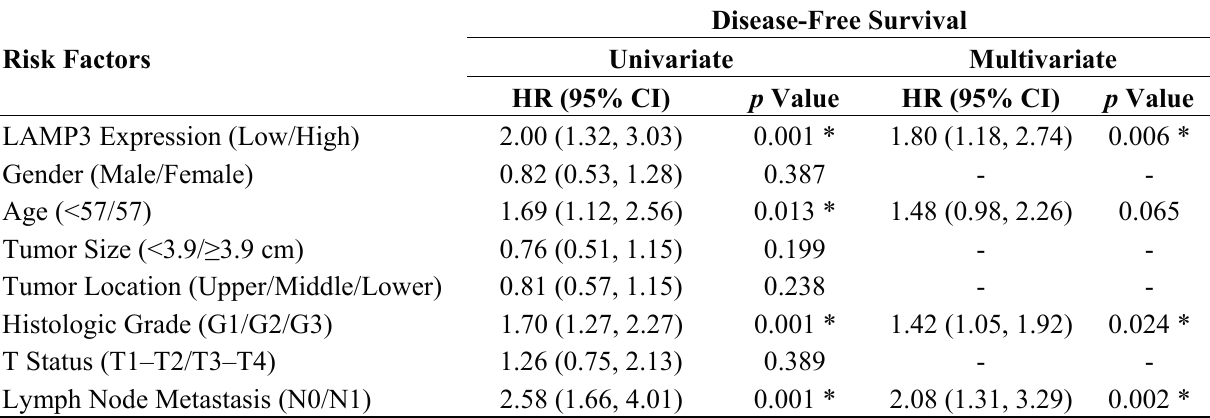
Table 3. Univariate and multivariate survival analysis for disease-free survival according to the Cox regression